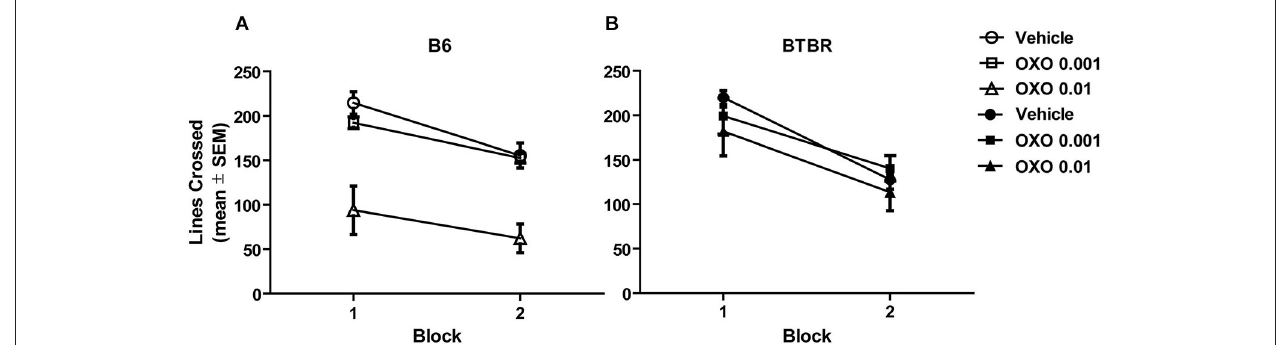
Oxotremorine 0.01 mg significantly reduced locomotor activity compared to that of other treatment groups. B6: vehicle ( n = 8), 0.001 oxo ( n = 8), 0.01 oxo ( n = 8). (B) Locomotor activity in BTBR mice. Activity decreased in the second 10-min block compared to the first. Oxotremorine treatment did not affect activity compared to that of vehicle treatment. BTBR: vehicle ( n = 8), 0.001 oxo ( n = 8), 0.01 oxo ( n =